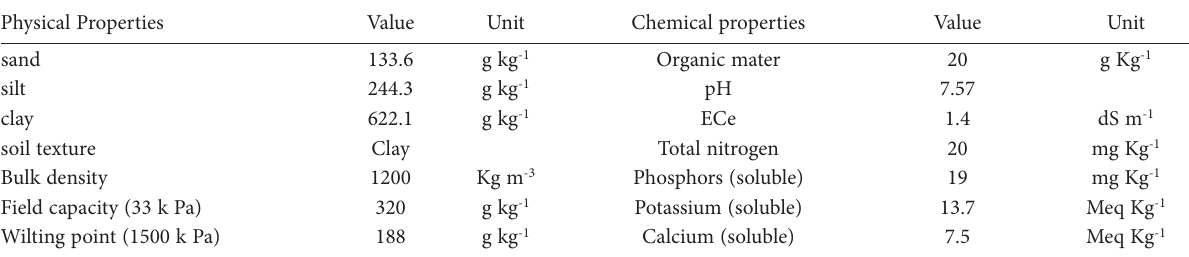
Table 1. Soil physical and chemical properties of the experimental site. Physical